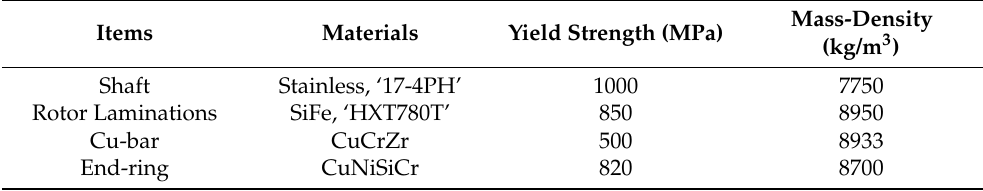
Table 4. Materials for 150 kW, 50 krpm induction